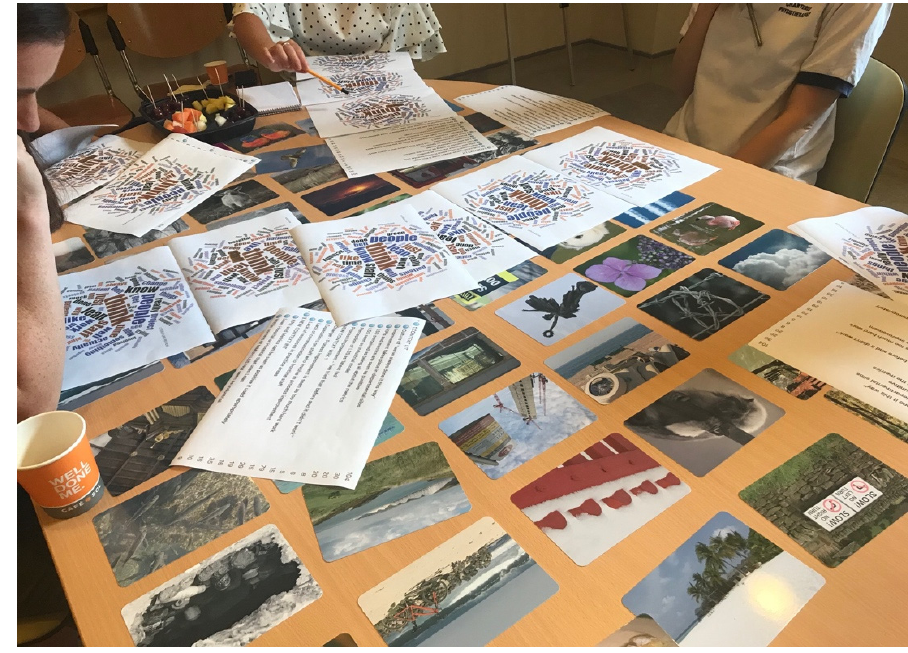
Figure 6. Use of Evoke© cards (source authors).